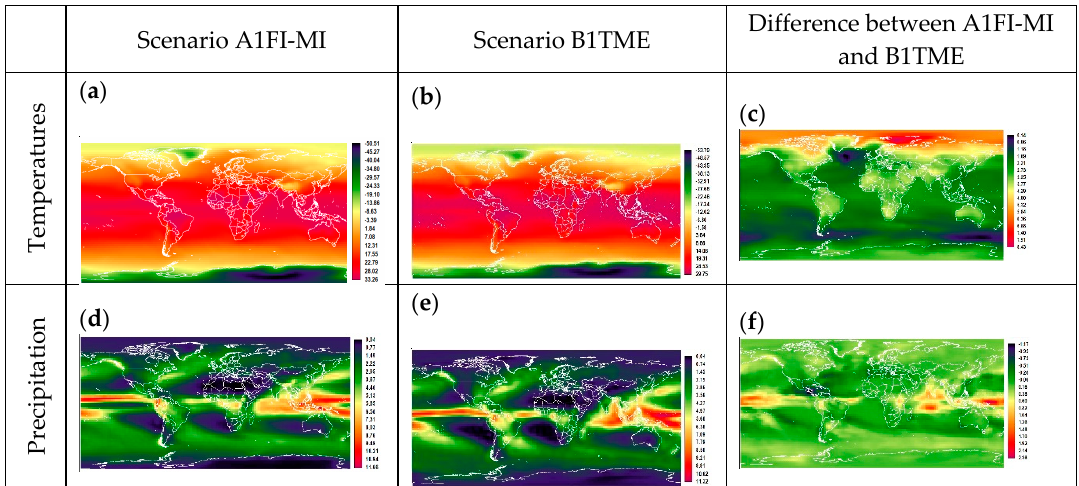
Figure 2. Projected global annual average temperature change in degree Celsius and annual precipitation change in mm/day by 2100 based on scenario A1FI-MI and B1TME ( a , b , d , e ). Difference between A1FI-MI and B1TME ( c , f ). Table 2. Summary of global statistics of annual temperatures under the two scenarios from Figure 2 images. Annual Temperatures ( ◦ C)